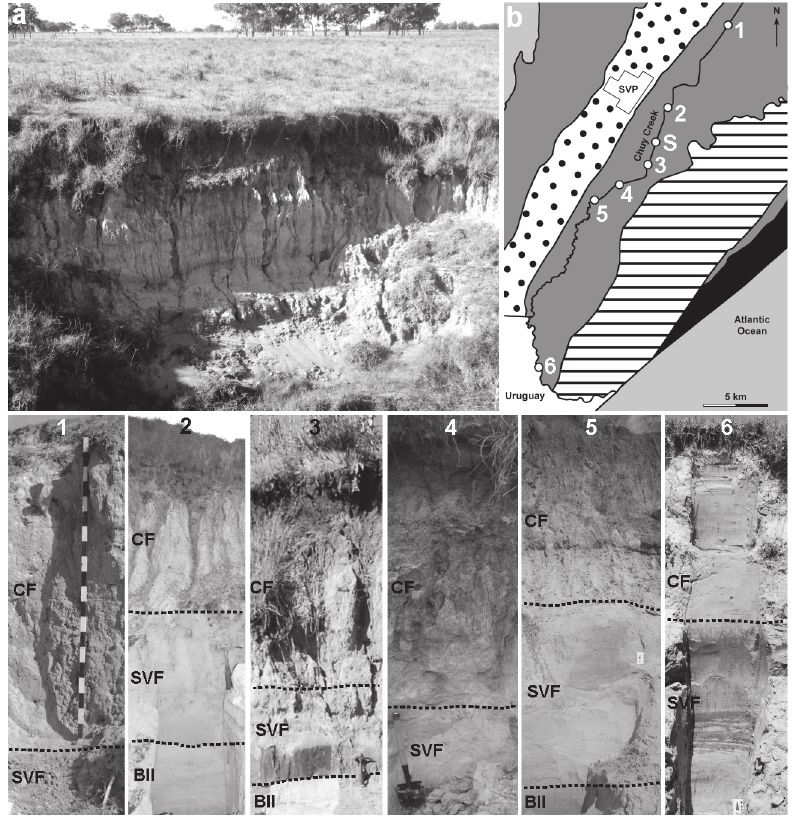
Figure 3 - a: The Cordão Formation exposed in a gully. b: Detail of the southernmost CPRS near the town of Santa Vitória do Palmar (SVP) with the location of the stratigraphic sections (1-6) below, exposed along Chuy Creek (SVP = Santa Vitória do Palmar, S = stratotype section shown in Figure 2, BII = Barrier II, SVF = Santa Vitória Formation, CF = Cordão